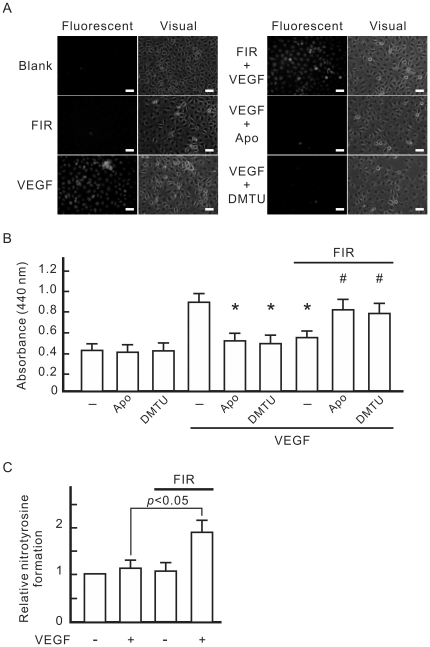
Involvement of VEGF-induced ROS in the inhibitory effect of FIR on VEGF-induced proliferation in HUVECs.(A) Detection of VEGF-induced intracellular reactive oxygen species (ROS). HUVECs were incubated for 30 min with culture medium containing DCF, and then treated with 10 ng/ml VEGF, 1 mM apocynin (Apo), 10 mM dimethylthiourea (DMTU), or FIR exposure at 0.13 mW/cm2 for 30 min as indicated. Cells were observed by fluoromicroscopy with excitation and emission wavelengths of 485 and 530 nm, respectively, and a photomicrograph is shown in the right panel of each group. Scale bar = 50 µm. (B) The influence of ROS scavengers on VEGF-induced cell proliferation. HUVECs were pretreated as indicated, and then cultured overnight. Data are shown as the mean±S.D. from six experiments. * p<0.05 vs. the group treated with VEGF alone. #
p<0.05 vs. the group treated with VEGF and FIR exposure. (C) Detection of nitrotyrosine formation. HUVECs were pretreated as indicated, and then cultured for 1 h. The nitrotyrosine formation data obtained from ELISA measurements are expressed as relative quantity (means±S.D. of 9 determinations in three cell preparations).